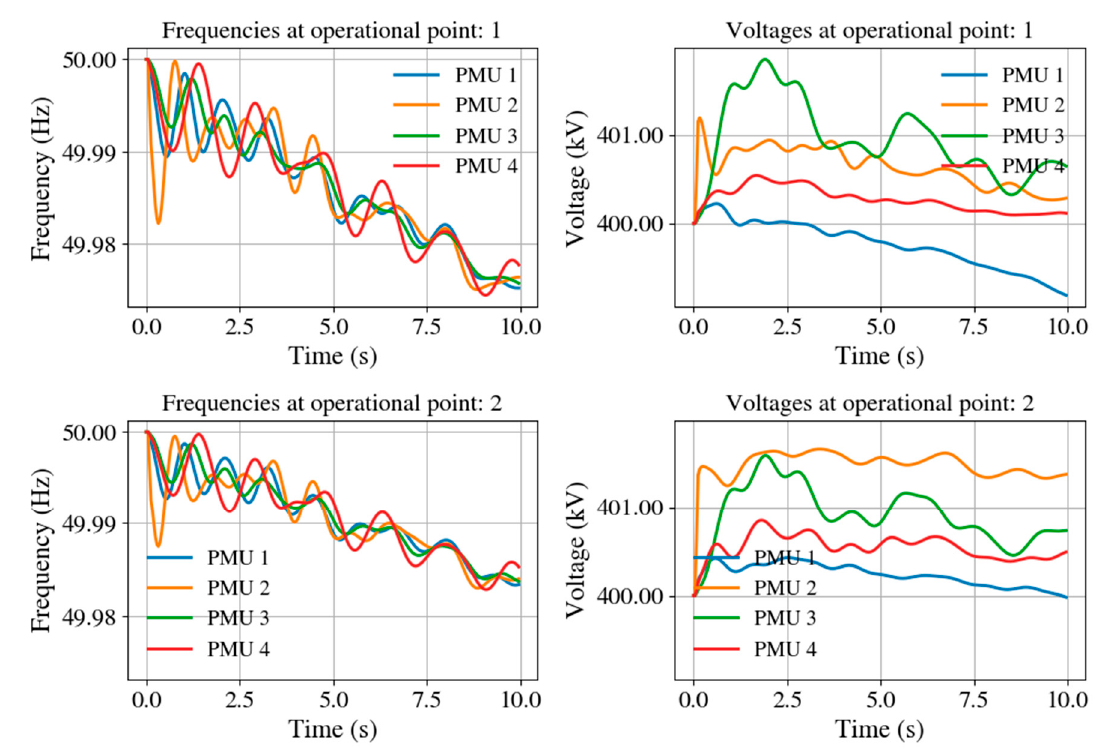
Figure 10. Exemplary simulations of four PMUs for a partial PV outage at station 2D3 (50% loss of installed capacity) including frequencies ( top and bottom left ) and voltage magnitudes ( top and bottom right ) for two operational points